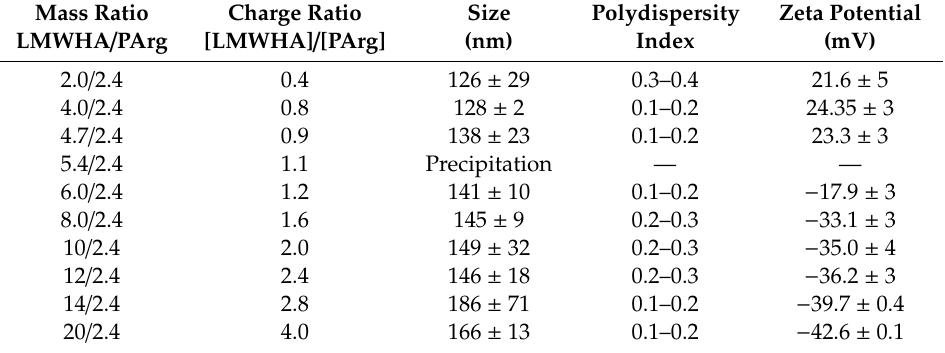
Table 1. Physicochemical properties of formulations prepared with different ratios of low-molecular- weight hyaluronic acid/polyarginine (LMWHA/PArg) and evaluated in Milli-Q water (mean ± SD, n = 3). Table1. Physicochemicalpropertiesofformulationspreparedwithdifferentratiosoflow-molecular-weight hyaluronic acid / polyarginine (LMWHA / PArg) and evaluated in Milli-Q water (mean ± SD, n = 3).